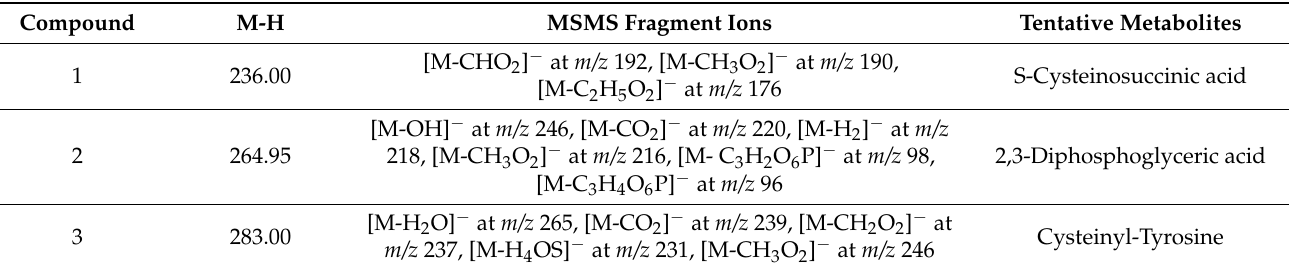
Table 6. Tentative endogenous metabolites in the serum of zebrafish fed with pure and adulterated honey were identified using LC-MS/MS fragmentation based on negative mode ionization.